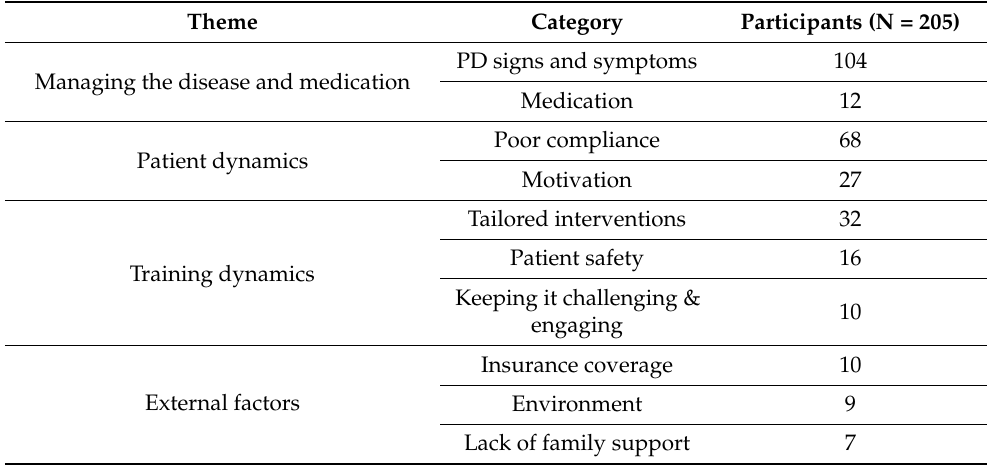
Table 2. Difficulties faced by healthcare and exercise professionals when providing DTT with people with